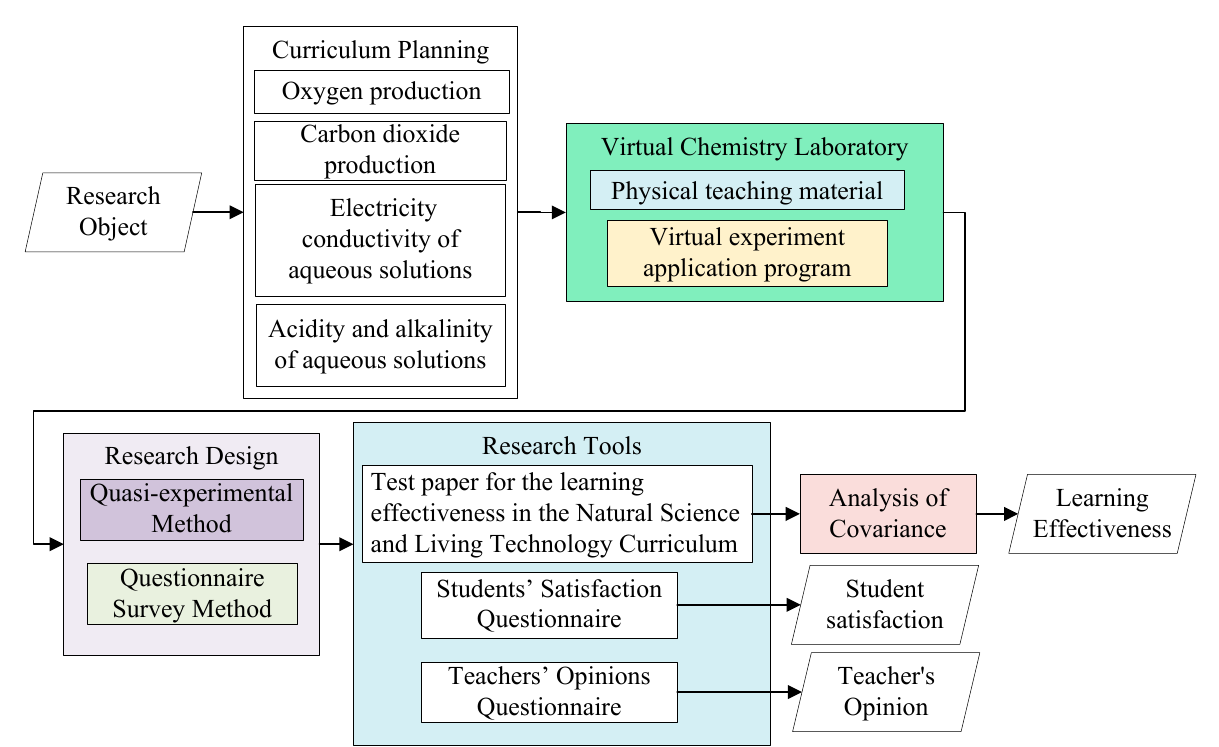
Figure 1. Architecture of the research method used in this study.